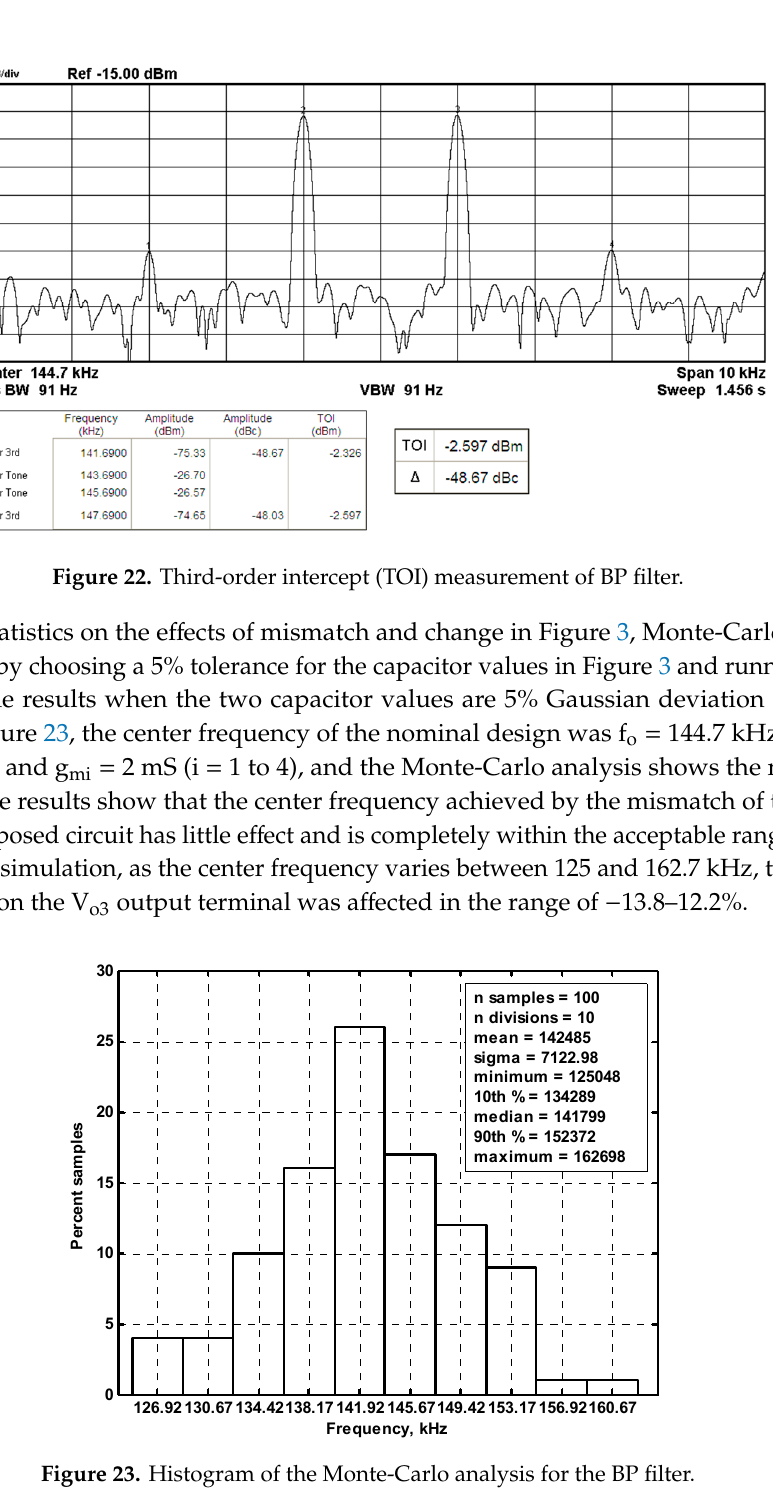
Figure 21. Measured P1dB of the BP filter with the input power of the voltage output V o3 .